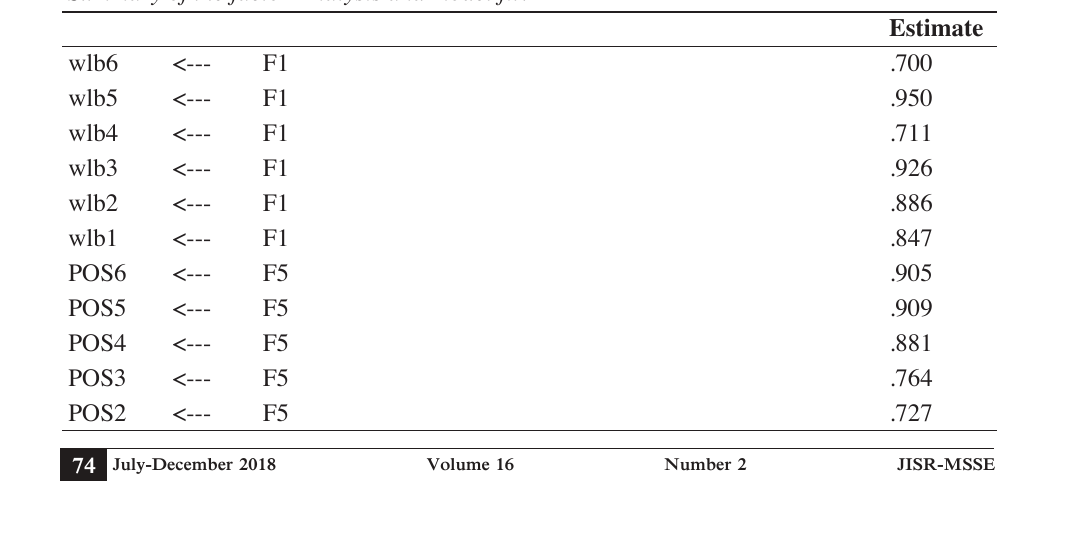
Summary of the factor Analysis and model